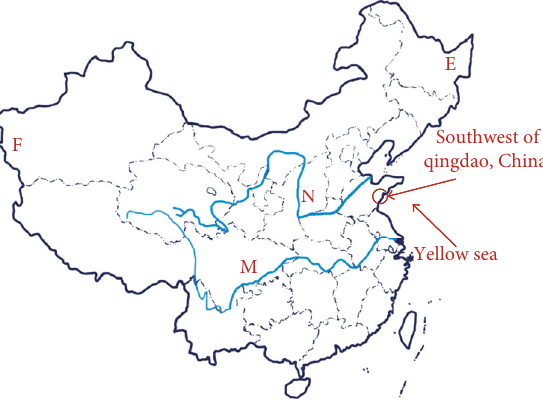
Figure 1: Location map of Qingdao engineering projects. Table 1: The similarity ratio relationship of each index in the